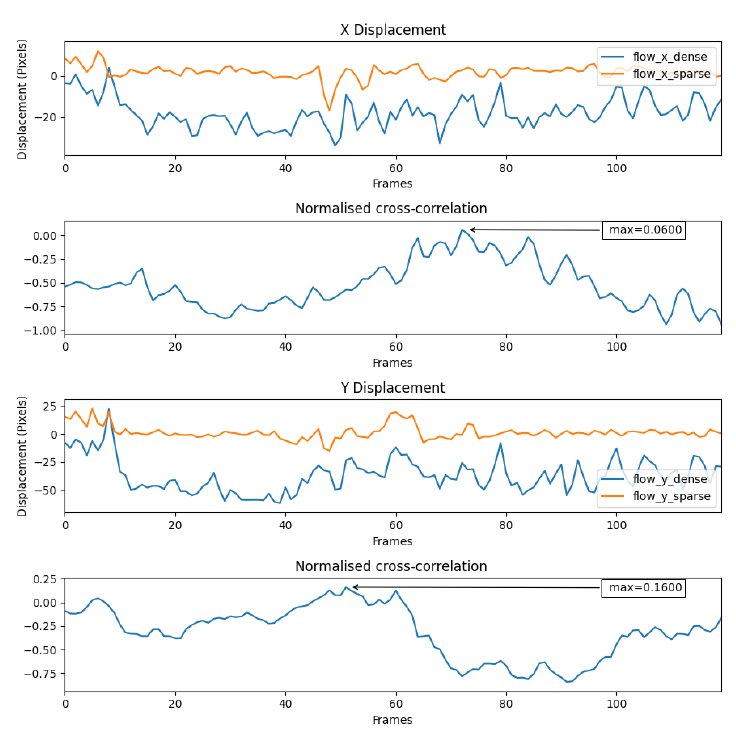
Figure 17. Dense and sparse technique signals on dataset 2 during low thermal contrast.